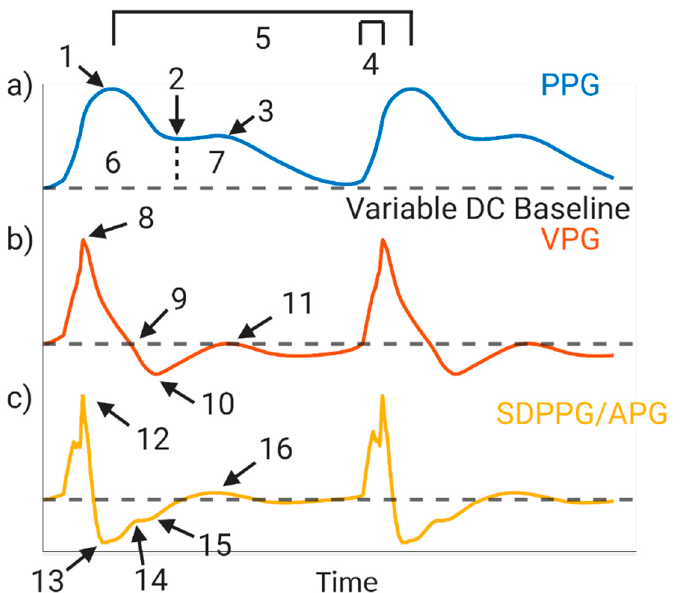
Figure 1. ( a ) Photoplethysmography (PPG) waveform: 1. systolic peak; 2. dicrotic notch; 3. diastolic peak; 4. slope transit time; 5. heart rate; 6. area under systolic waveform; 7. area under diastolic waveform; ( b ) first derivative, velocity plethysmograph (VPG): 8. max slope in systole; 9. end of systolic peak; 10. Start of dicrotic notch; 11. max slope in diastole; ( c ) second derivative, second derivative photoplethysmograph or acceleration plethysmograph (SDPPG/APG): 12. a-point; 13. b-point; 14. c-point; 15. d-point; 16. e-point. Created with BioRender.com.